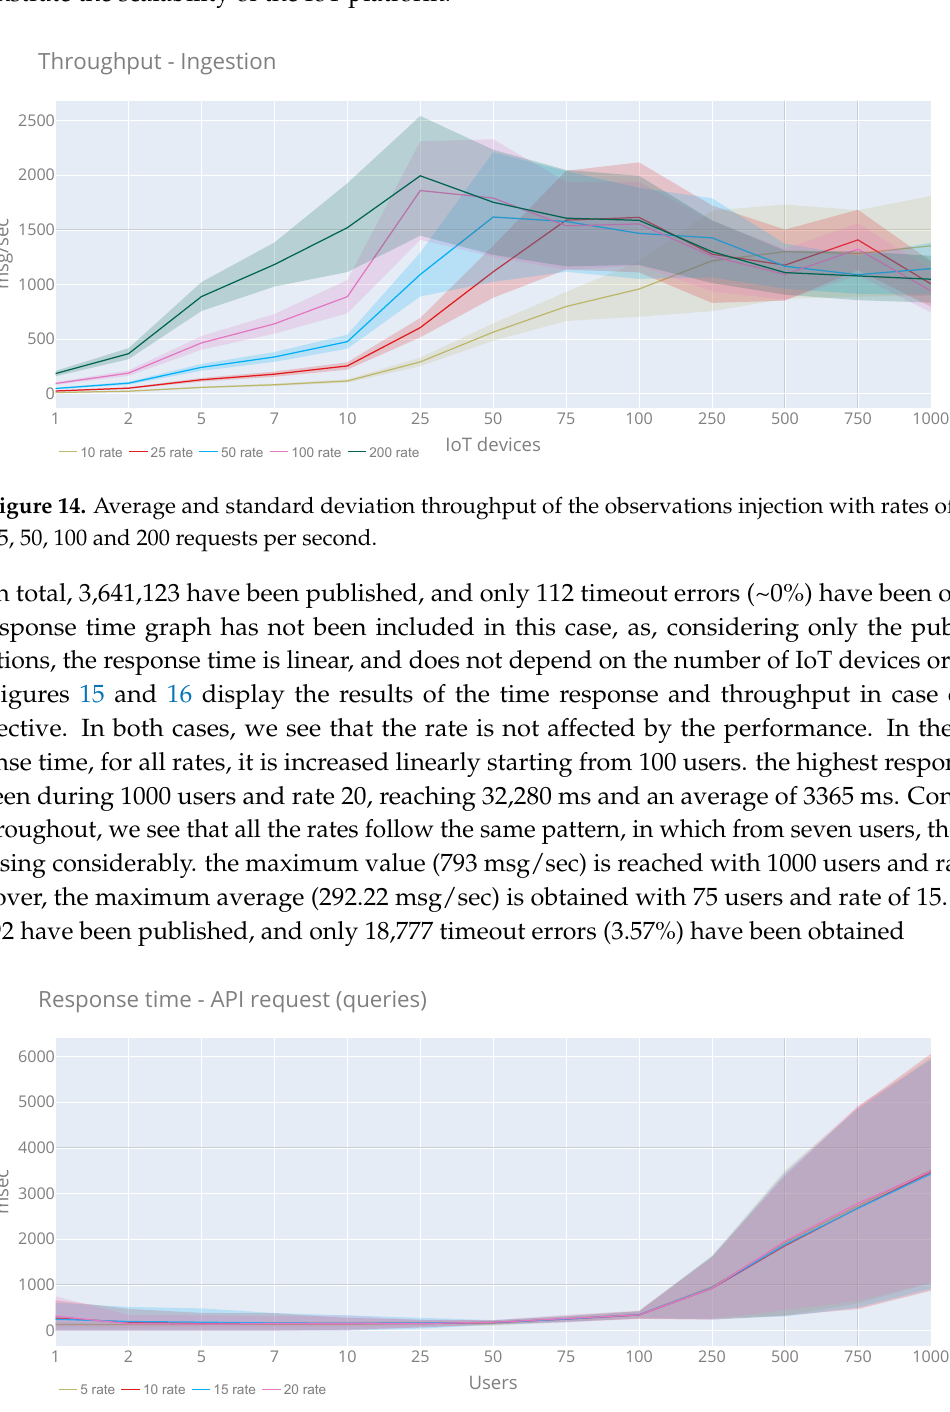
Figure 15. Average and standard deviation response time of API queries with a rate of 5, 10, 15 and 20 requests per